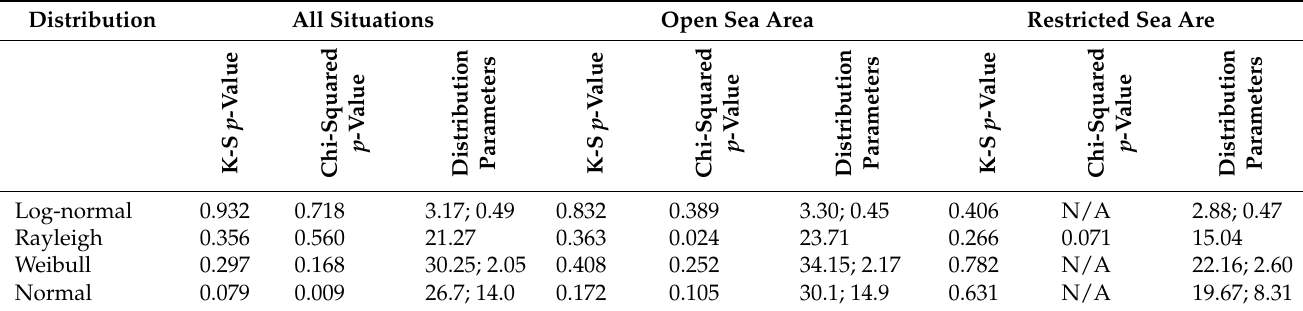
Table 5. p -values and distributions parameters calculated for the TCPA at the start of the anti-collision manoeuvre. Distribution